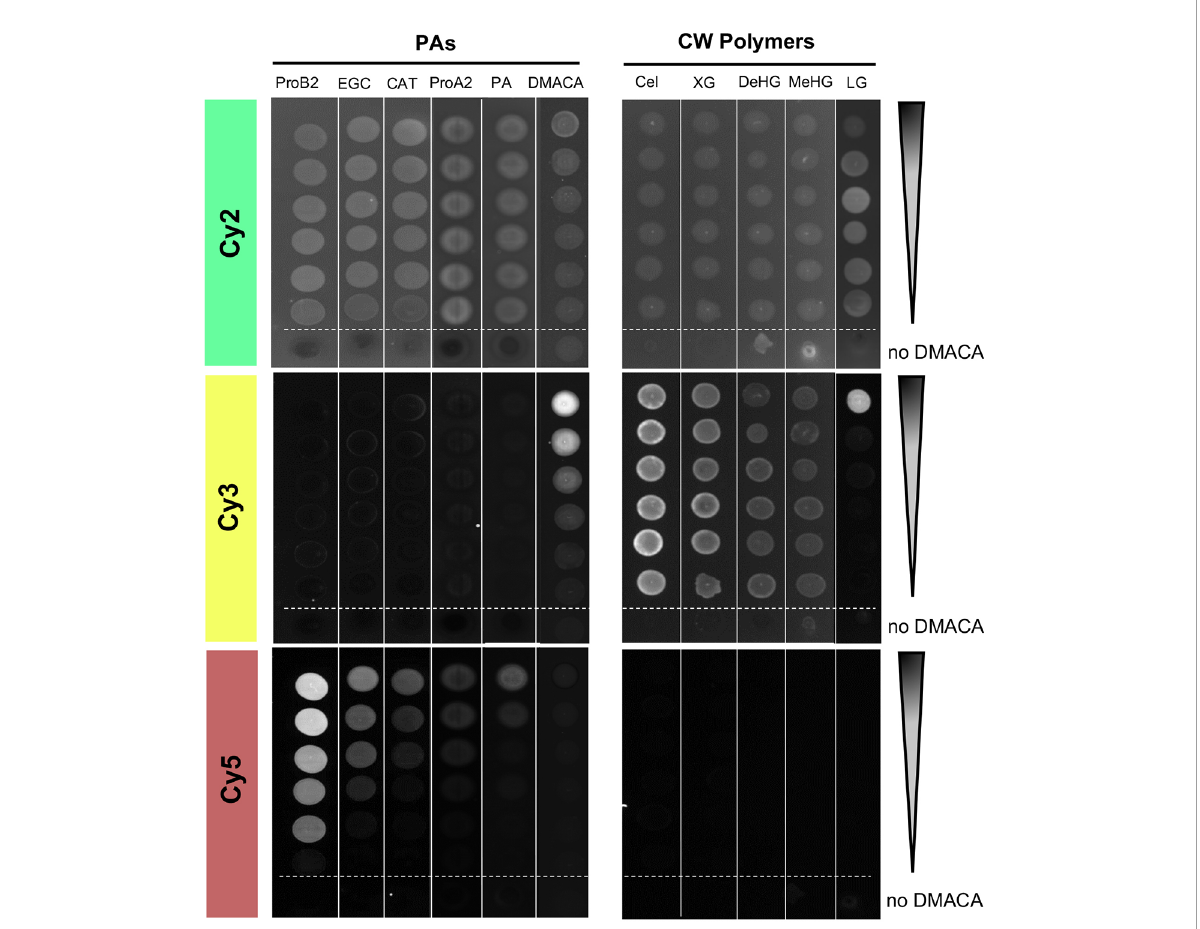
FIGURE 2 Fluorescent spot test (FST) of DMACA fl uorescence (excitation l ex , emission = l em ) with different PA species and cell wall polysaccharides. Fluorimeter settings for three channels: Cy2: l ex = 492 nm, l em = 510 nm; Cy3: l ex = 550 nm, l em = 570 nm; Cy5: l ex = 650 nm, l em = 670 nm. Dilutions started at 1 mg/mL for PAs and lignin and 10 mg/L for polysaccharides. At each dilution step, the concentration was halved. Arrows indicate the direction of the concentration gradient. The bottom spot (below the dashed line) in each series was recorded for only solvent (acidic alcohol, missing DMACA) with the respective substrate. ProA2, procyanidin A2; ProB2, procyanidin B2; EGC, ( − )-epi-gallocatechin; CAT, (+)-catechin; PAs, proanthocyanidins from roots of Populus tremula ; Cel, cellulose; XG, xyloglucan; DeHG, demethylesteri fi ed homogalacturonan; MeHG, methylesteri fi ed homogalacturonan and LG,